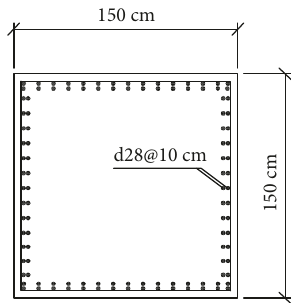
Figure 16: Pier reinforcement detail (cross